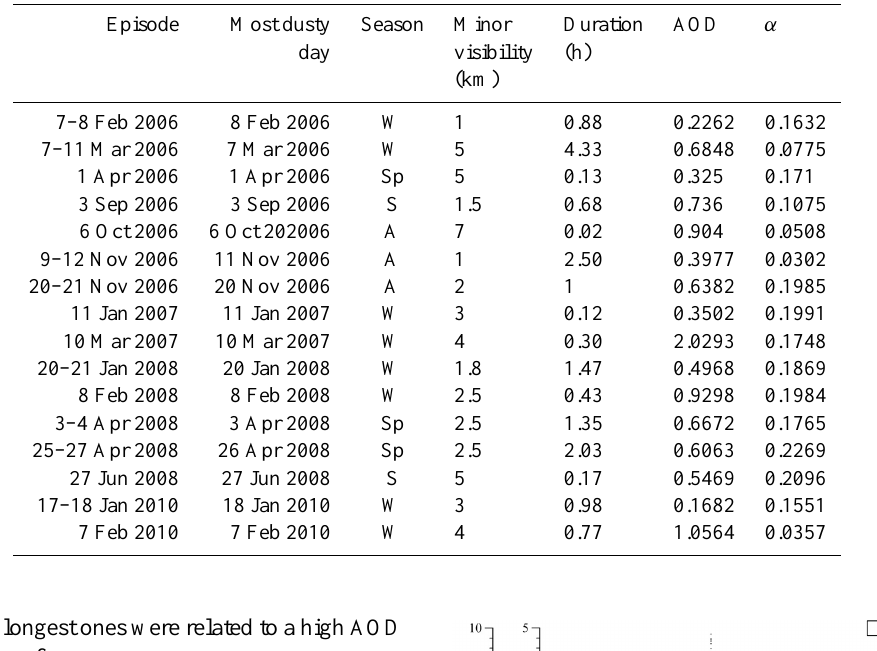
Table 1. Dust episodes encoded in METARs. Duration in hours and minor visibility in km for the Canaries. AOD 675